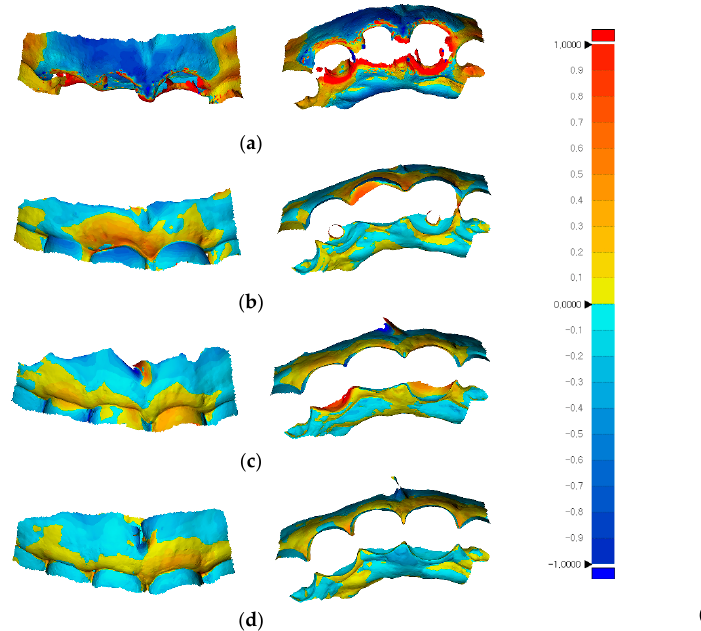
Figure 7. Soft tissue dimensional changes around sites of rehabilitation, shown as color maps using reverse engineering software (Geomagic Control X version 2018.0.1, 3D Systems, Cary, NC, USA); ( a ) Superimposition of the 2-month postoperative state over the state exhibited immediately after extraction (RMS: 757.6 µ m); ( b ) Superimposition of the 4-month postoperative state over the 2-month postoperative state (RMS: 221.1 µ m); ( c ) Superimposition of the 6-month postoperative state over the 2-month postoperative state (RMS: 286.7 µ m); ( d ) Superimposition of the 1-year postoperative state over the 6-month postoperative state (RMS: 128.1 µ m). RMS, Root mean square; ( e ) Color-scale bar showing maximum and minimum critical values of ± 1,000 µ